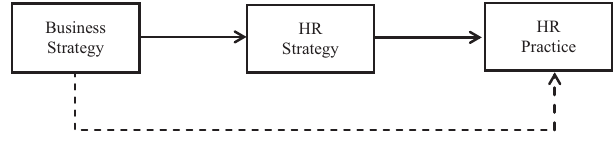
Figure 1. The contingent relationships of